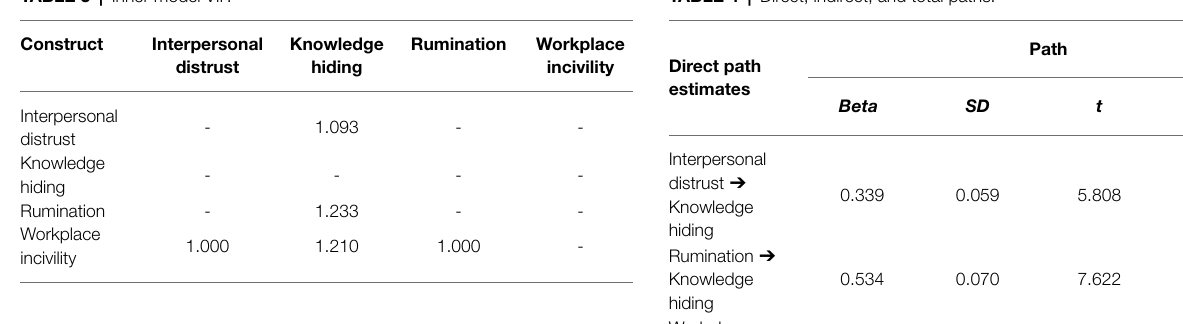
TABLE 2 | Fornell and Larcker (1981); Criteria, HTMT, R-square, and Q-square. Construct Interpersonal Knowledge distrust hiding